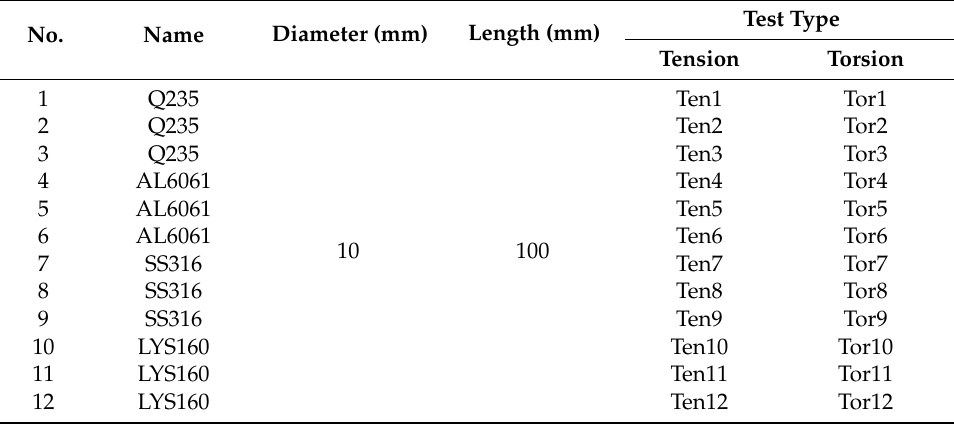
Table 1. Details of the monotonic test